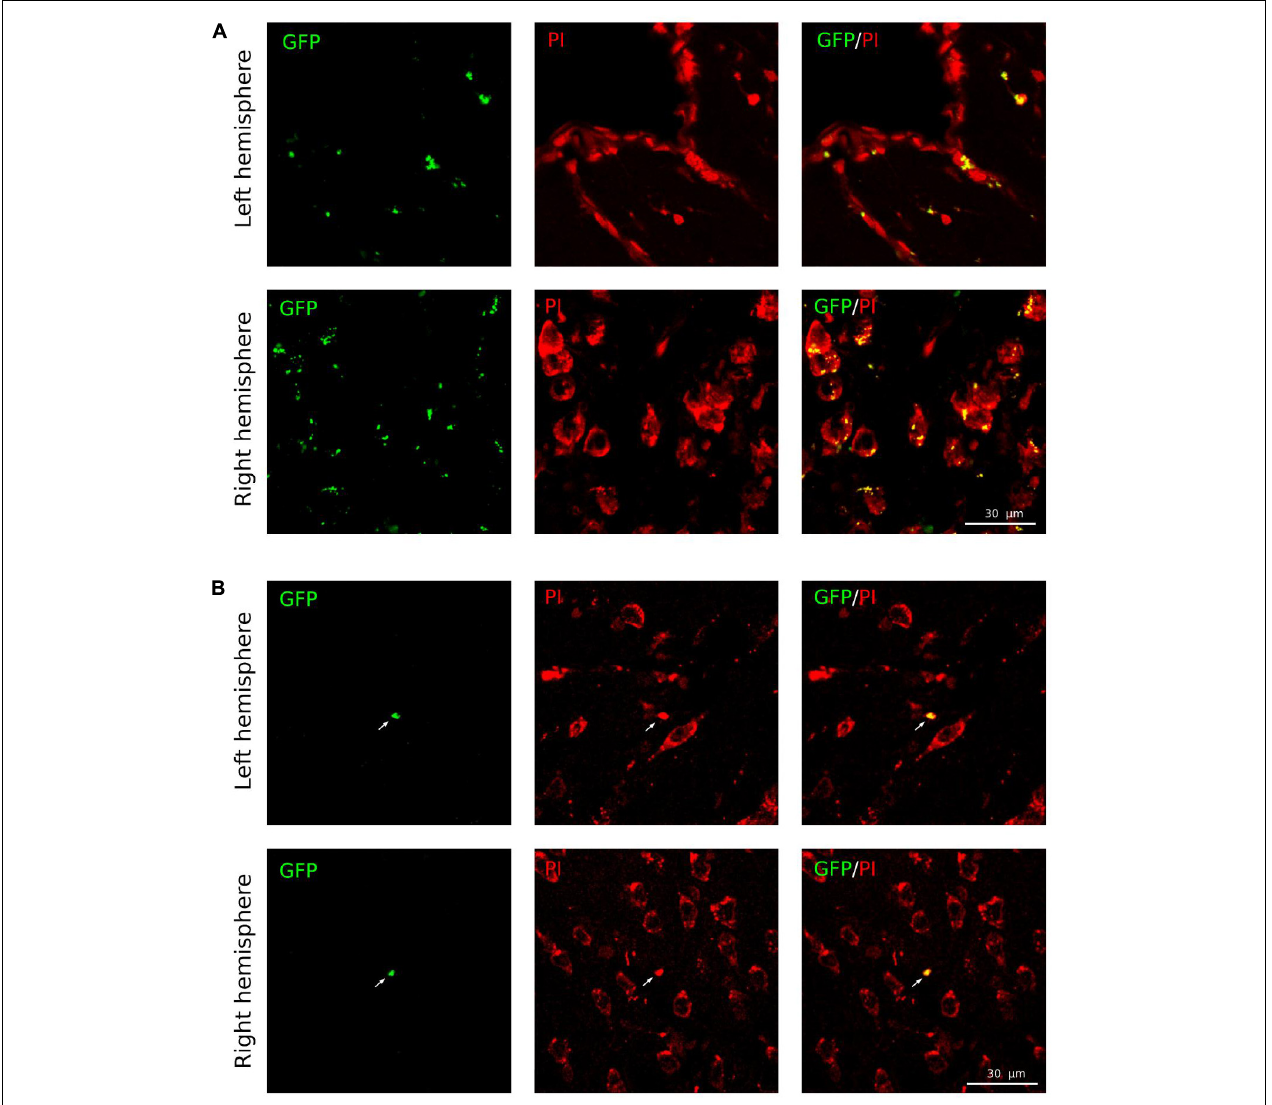
FIGURE 5 | Expression of the reporter GFP gene in brain cortex 21 days after intrathecal infusion of Ad-GFP or UCB-MC+Ad-GFP. (A) Transduction of brain cortex cells with Ad-GFP in the ischemic left and right hemispheres. (B) Expression of GFP in UCB-MC ex vivo transduced with Ad-GFP in the ischemic left and right hemispheres. Green, GFP; red, propidium iodide (PI). Scale bar = 30 µ